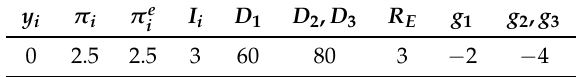
Table 3. Initial values of the three-country monetary union.